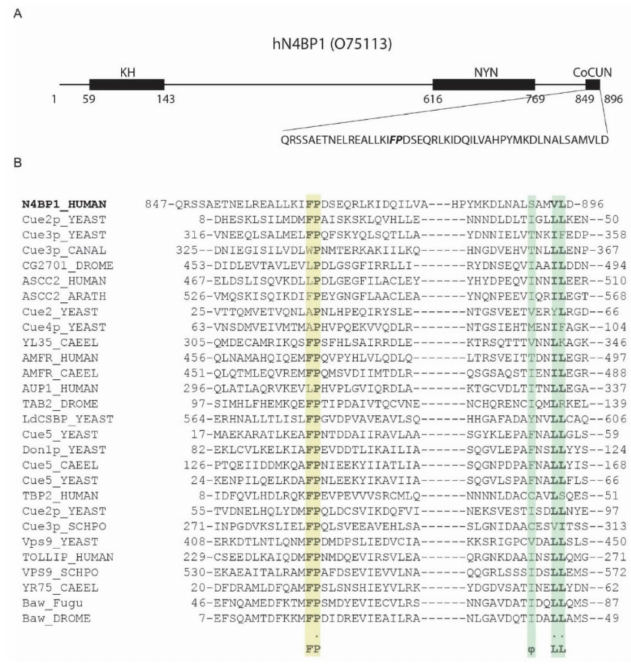
Figure 1. The ubiquitin-binding domain of NEDD4 binding protein 1 (N4BP1) resembles a ubiquitin conjugation to ER degradation (CUE) domain. ( A ) Domain organization of human N4BP1 (UniProt code O75113). The sequence of the carboxyl-terminal end of N4BP1 identified by phage display and spanning residues 813–896 is shown. ( B ) Comparative sequence analysis of the ubiquitin binding domains (UBD) of N4BP1 human with CUE domain containing proteins, performed with SMART search using as query sequence the amino acid region shown in ( A ). Colored backgrounds highlight the phenylalanine-proline (FP) pair with the invariant Proline (yellow) and the C-terminal hydrophobic motif (green).